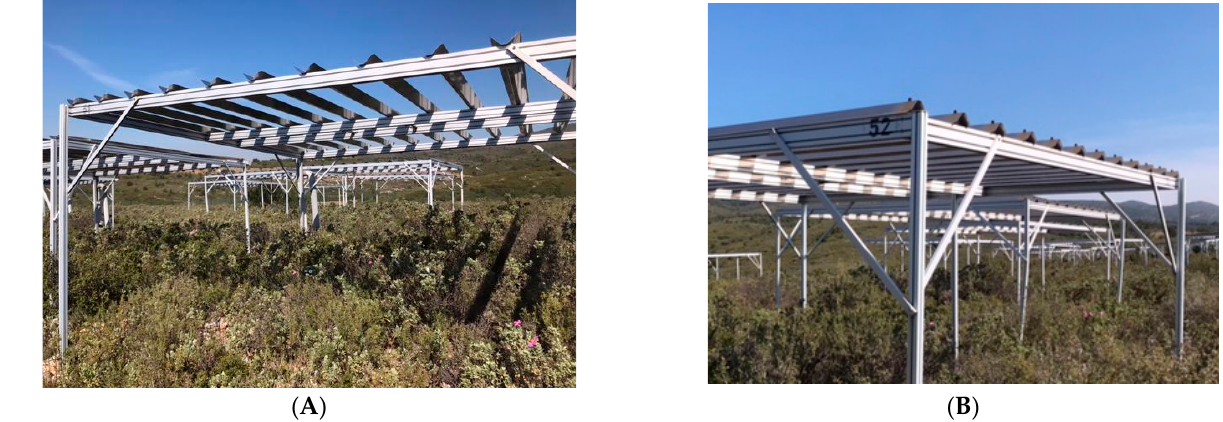
Figure 1. The CLIMED site with rain-exclusion ( A ) and control ( B ) devices.